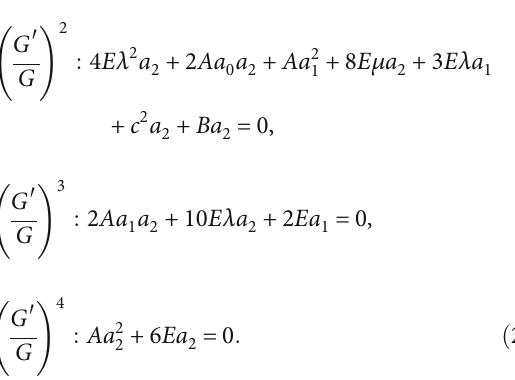
Maple symbol computing system, and the following